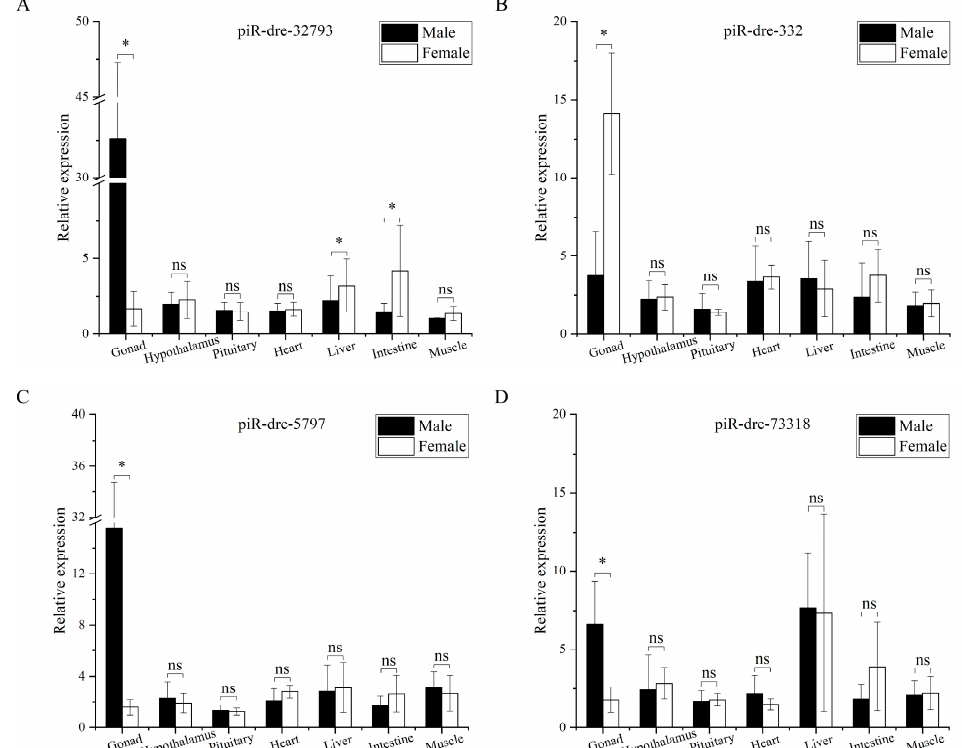
Figure 6. Real-time quantitative polymerase chain reaction verification of four piwi-interacting RNA expression patterns in seven different tissues from three male and three female greater amberjacks. The x -axis represents different tissues (gonad, hypothalamus, pituitary, heart, liver, intestine, and muscle) from the male and female group, and the y -axis represents the relative expression of piwi-interacting RNAs in the male and female group. The black column (left column) represents the relative expression of piRNAs in the male group, and the white column (right column) represents the relative expression of piwi-interacting RNAs in the female group. Data are presented as the mean ± SD, n = 3. *, p < 0.05. ns, p > 0.05. ( A ) piR-dre-32793. ( B ) piR-dre-332. ( C ) piR-dre-5797. ( D ) piR-dre-73318.